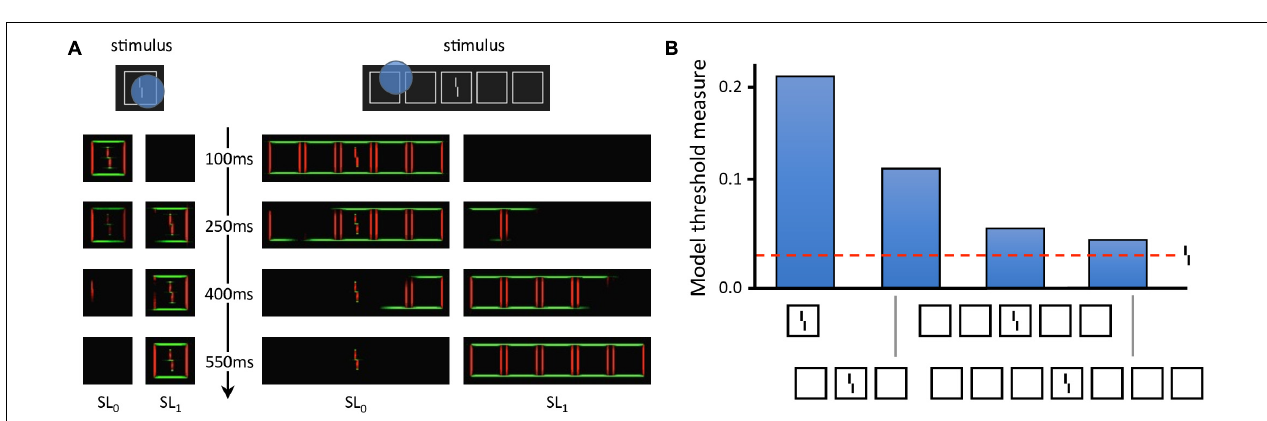
FIGURE 4 | Laminart model. (A) Activity in the segmentation model. The intensity of each pixel corresponds to the activity of an orientation-selective neuron encoding the stimulus as a local feature detector. The color of the pixel represents the orientation of the most active neuron at that location (red: vertical, green: horizontal). Visual elements linked together by illusory contours form a potential group. The blue circles mark example locations at which the segmentation dynamics are initiated after stimulus onset. From these locations, thanks to recurrent processing, segmentation propagates along connected (illusory or real) contours, until the stimulus is represented by several distinct neural populations, called segmentation layers (two here: SL 0 and SL 1 ). Each segmentation layer represents a perceptual group. Crowding is high if other elements are grouped in the same population as the Vernier target, and low if the target is alone. On the left, the flanker is hard to segment because of its proximity to the target. Across the trials, the selection signals often overlap with the whole stimulus, considered as a single group. Therefore, the flanker interferes with the target in most trials, and crowding is high. On the right, the flankers are linked by illusory contours and form a group that spans a large surface. In this case, the selection signal can easily hit the flankers group without hitting the target. The Vernier target thus ends up alone in its layer in most trials and crowding is low. (B) Threshold measurement from the segmentation model’s output for all conditions of Figure 2B . The model threshold is measured by matching the output of the model to a target template over 20 segmentation trials, and then plotting the mean of the template match on a reversed axis [see Francis et al. (2017) for more details]. The segmentation model generates uncrowding and fits the behavioral data